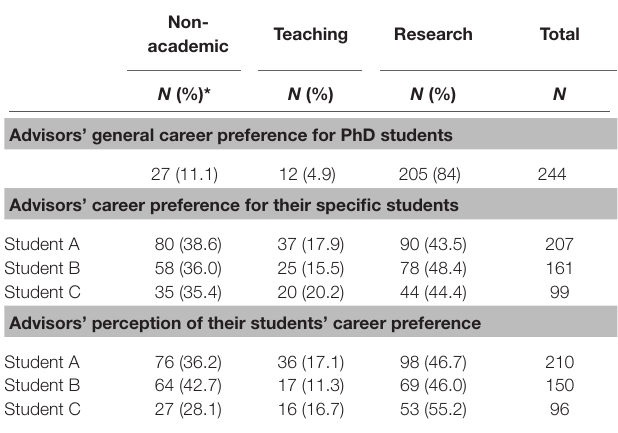
TABLE 5 | Frequency table for advisors’ own and perception of their students’ career